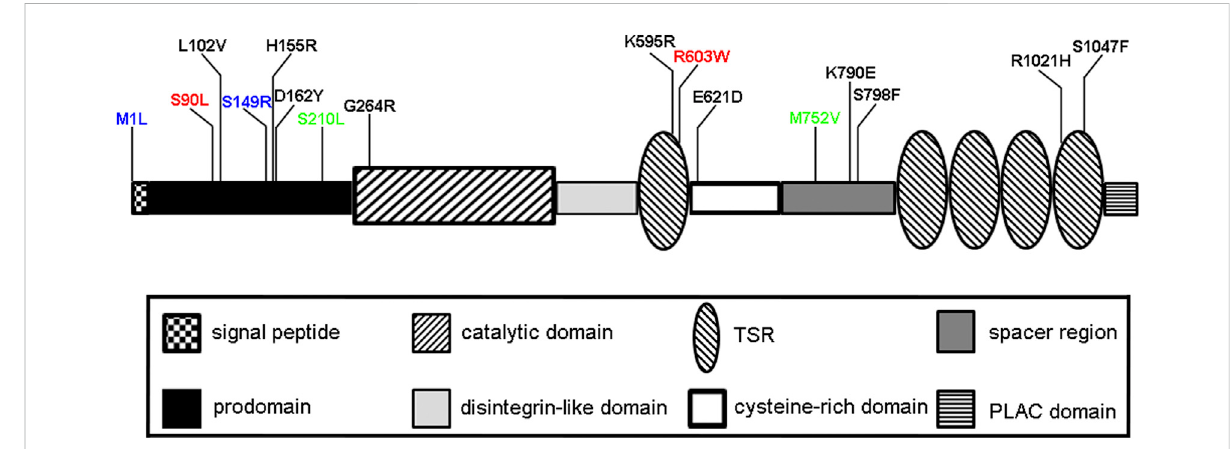
FIGURE 1 SchematicofADAMTS6domainstructureandallelicmutations.Mutationsshowninblue(M1L,S149R)arerecessivemutationsidenti fi edinmice that cause prenatal/neonatal lethality (Li et al., 2015). Two rare non-synonymous variants rs61736454 (p.Ser90Leu) and rs114007286 (p.Arg603Trp) areshown inred,predicted damaging variantsincardiac QRSintervalare showninblackandbenign-predictedvariants(S210L, M752V)are shownin green (Prins et al.,